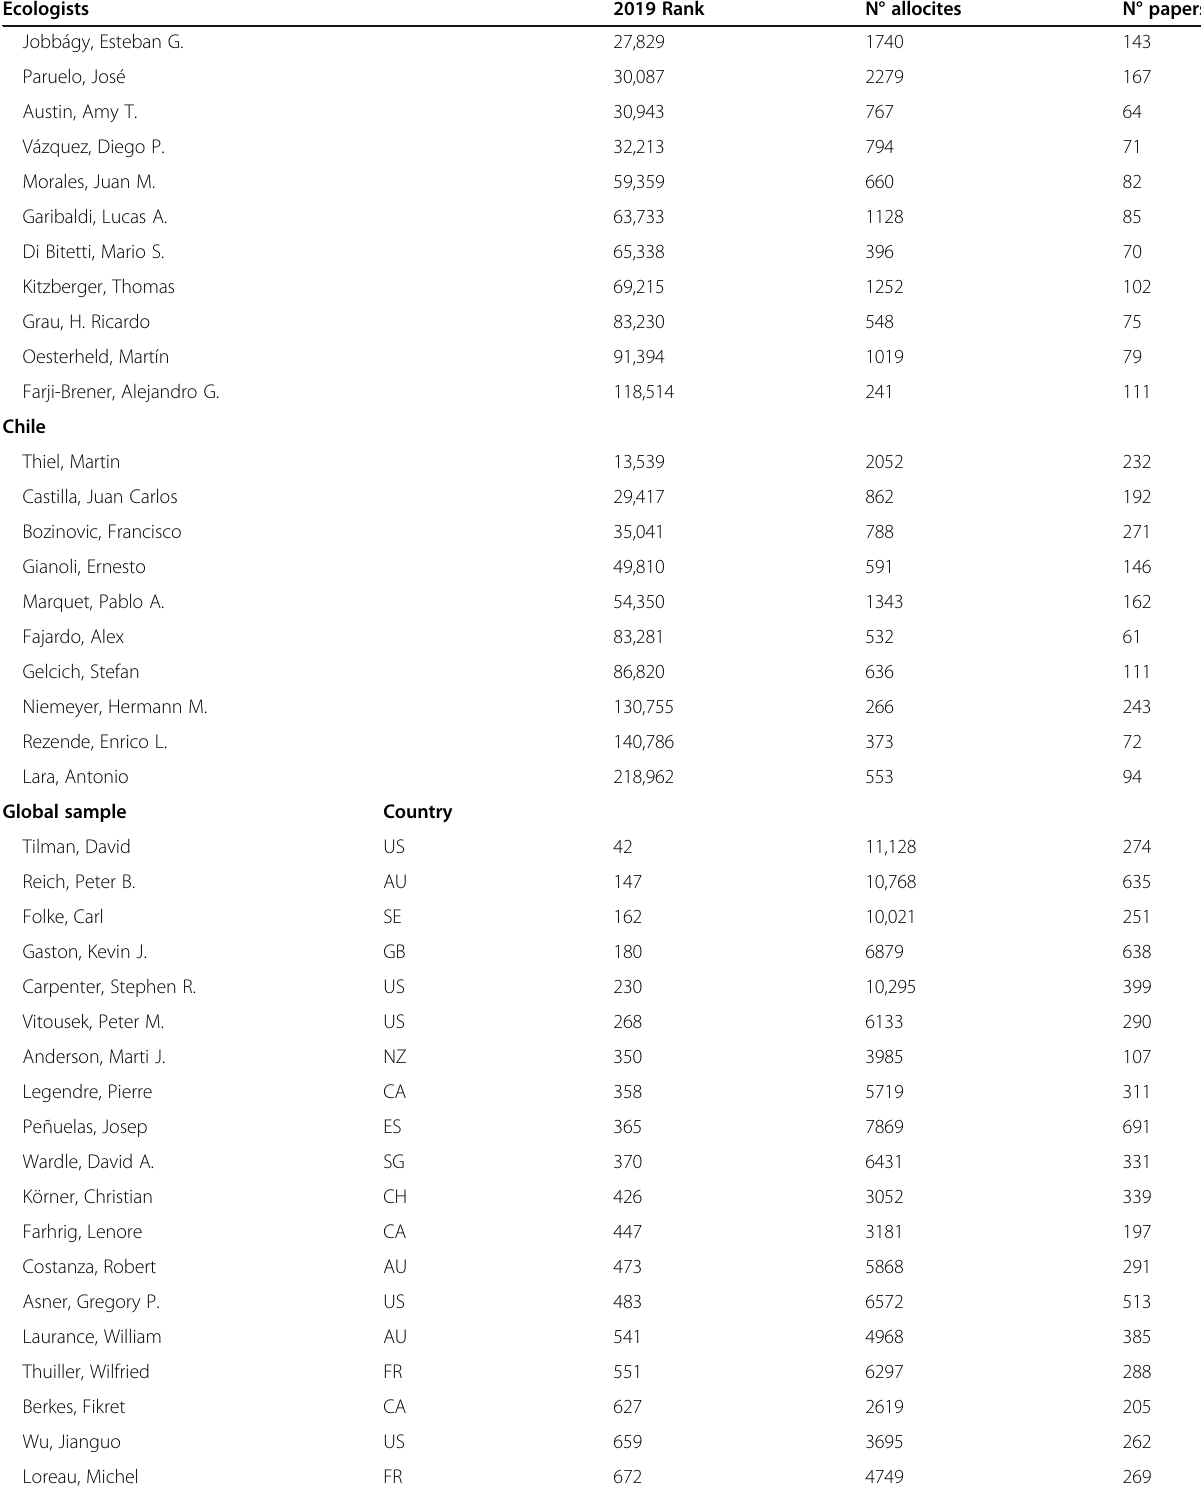
Table 4 Single-year (2019) impact ranking of Latin American ecologists, their No. allocites, and No. papers in the Scopus database (from Table S-7, 2019 Single-year ranking, by Ioannidis et al. [3]). For the global sample, countries are identified by their ISO 3166 Codes